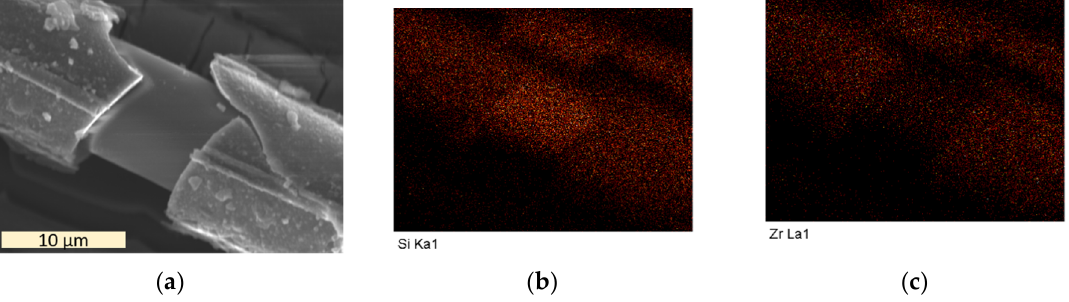
Figure 6. AR fibers submerged in 5% NaOH solution: ( a ) 28 d at 55 °C; ( b ) Silicon EDS mapping (Si); and ( c ) Zirconium EDS mapping (Zr).